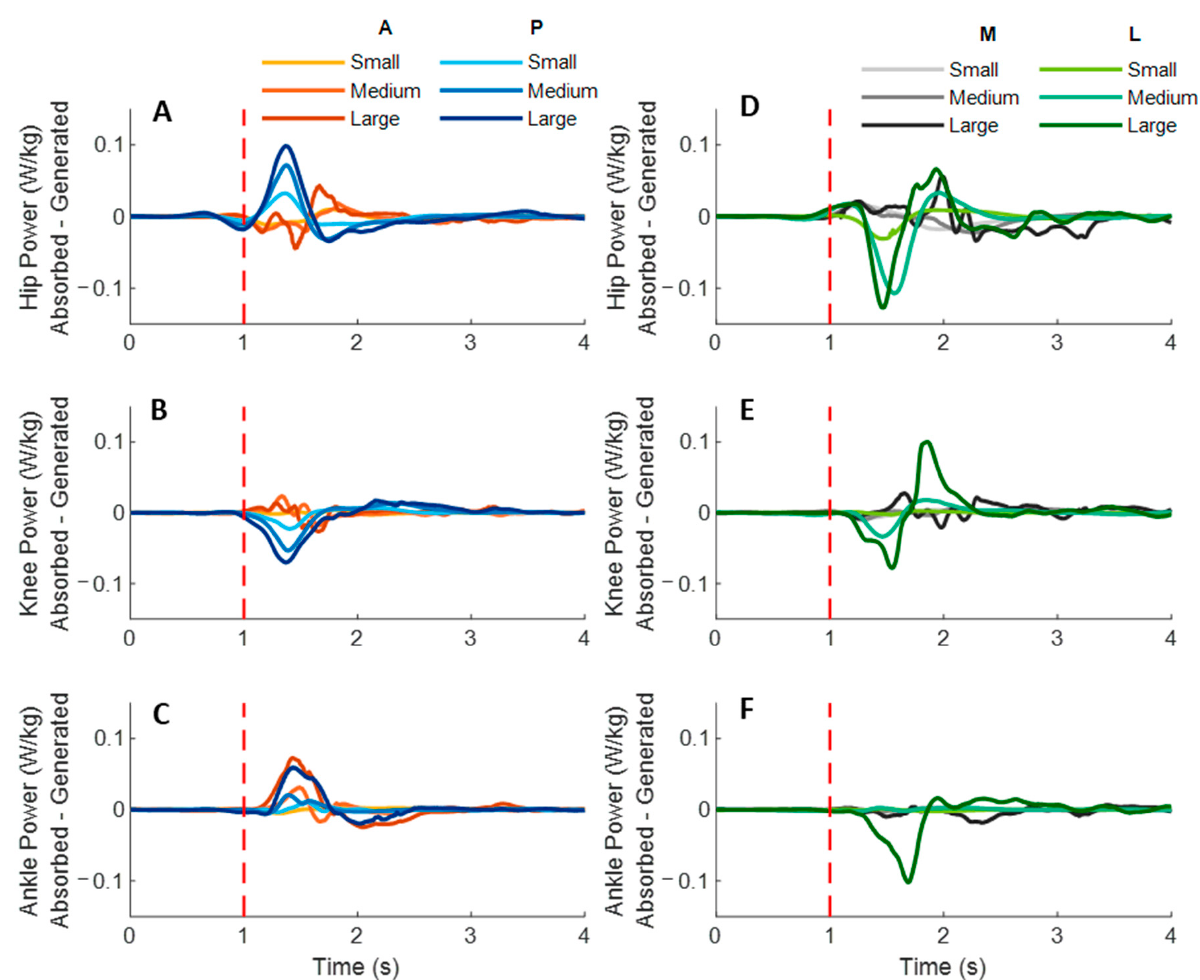
Figure 7. The mean dominant-leg joint power changes of twelve participants following the unex- pected anterior, posterior, medial, and lateral perturbations with three magnitudes ( n = 12). Mean hip ( A ), knee ( B ), and ankle ( C ) power generation and absorption following anterior and posterior perturbations; Mean hip ( D ), knee ( E ), and ankle ( F ) power generation and absorption following medial and lateral perturbations. (Note: The red dotted line indicated the start of pulling perturbation. A : anterior; P : posterior; M : medial; L : lateral).